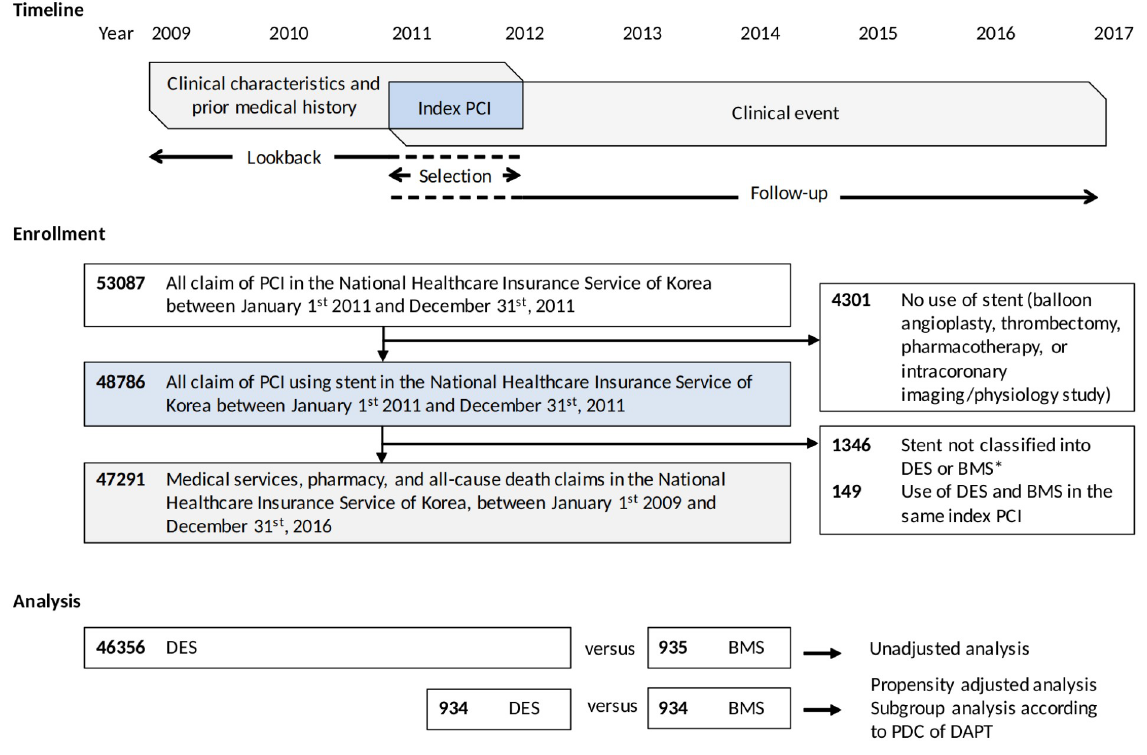
Fig 1. Study flow. � Stent without identified